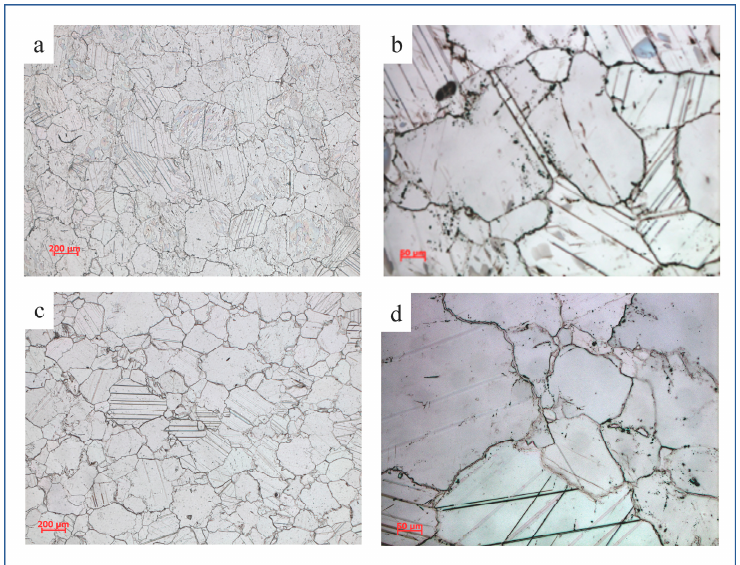
3 Figure 3. Photomicrographs at different scale of ultra-thin sections of marble in plane-polarized light. ( a,b ) NW sample (SMF1); ( c , d ) SE sample